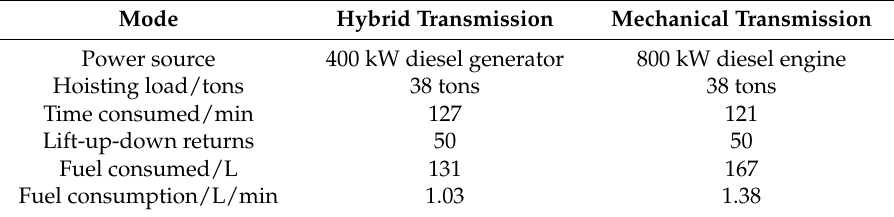
Table 3. Fuel consumption comparison results.